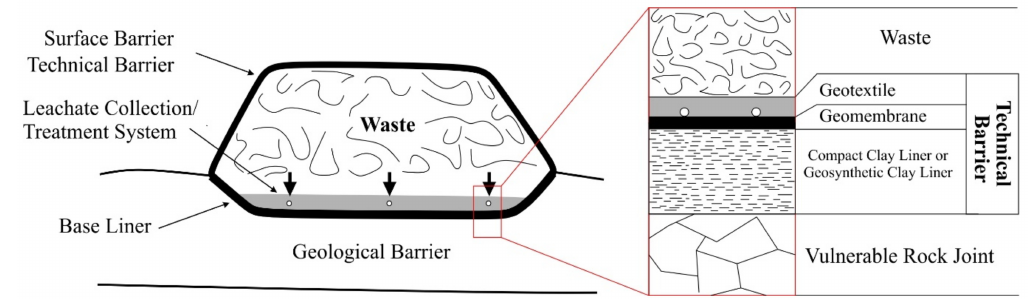
Figure 10. The conceptual model of the landfill design and scheme of basal composite liner systems for the Khon Kaen proposed waste disposal